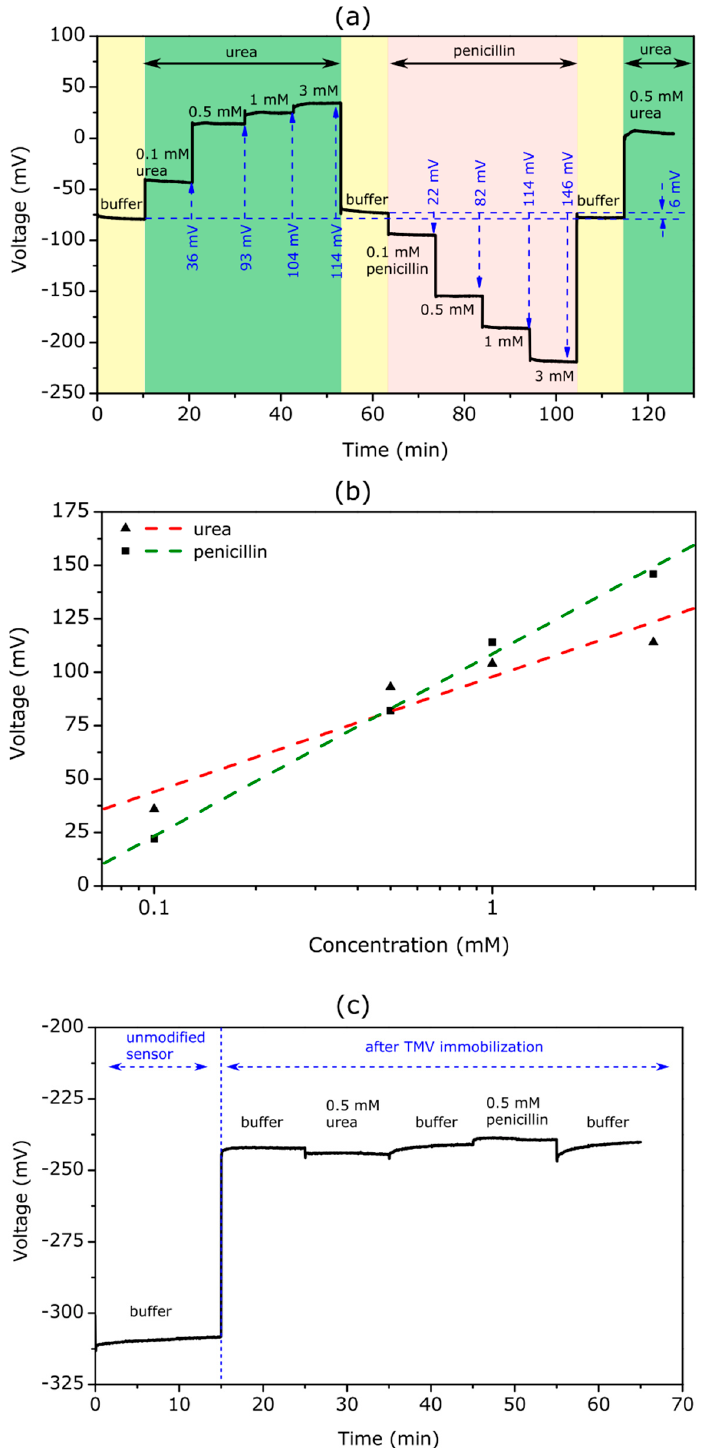
Figure 4. ( a ) ConCap curve of the TMV-assisted bi-enzyme EISCAP biosensor recorded in buffer and at different concentrations of urea and penicillin. ( b ) Calibration curves for urea and penicillin evaluated from the ConCap response in ( a ). ( c ) ConCap curve recorded with an EISCAP sensor before and after TMV loading (without enzymes) in 0.33 mM PBS (pH 7.4) and in 0.33 mM PBS (pH 7.4) with 0.5 mM urea and 0.5 mM penicillin, respectively.